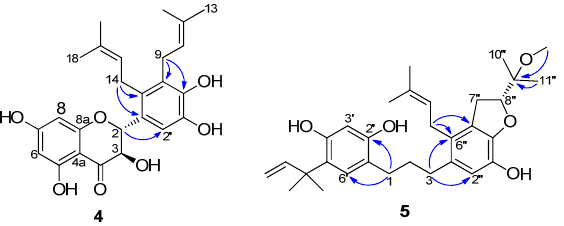
Figure 2. Key HMBC correlations ( 1 H → 13 C) of compounds 4 and 5